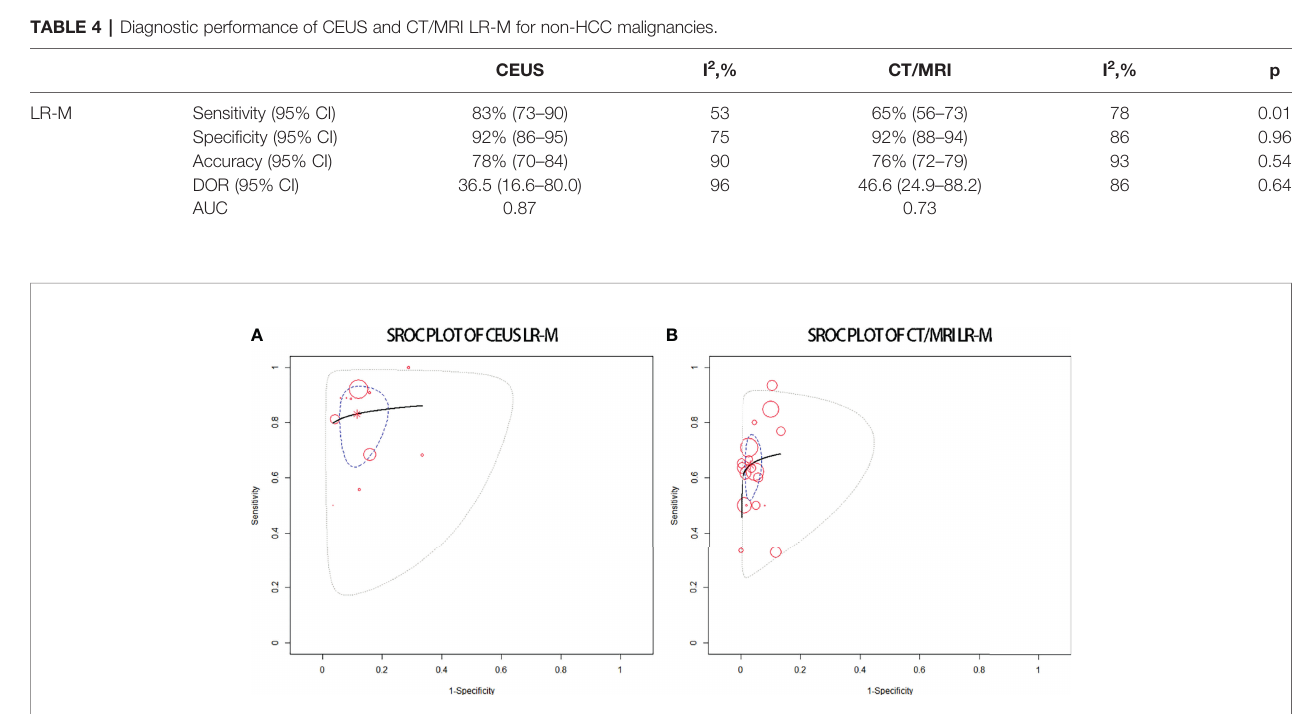
FIGURE 6 | sROC plots of CEUS LR-M (A) and of CT/MRI LR-M (B) for the diagnosis of non-HCC malignancies.